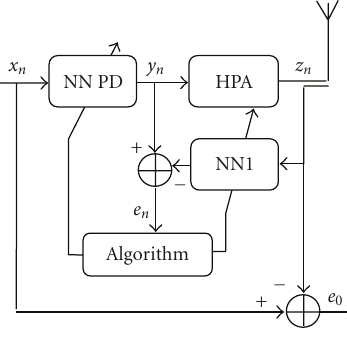
Figure 15: Simultaneous PD